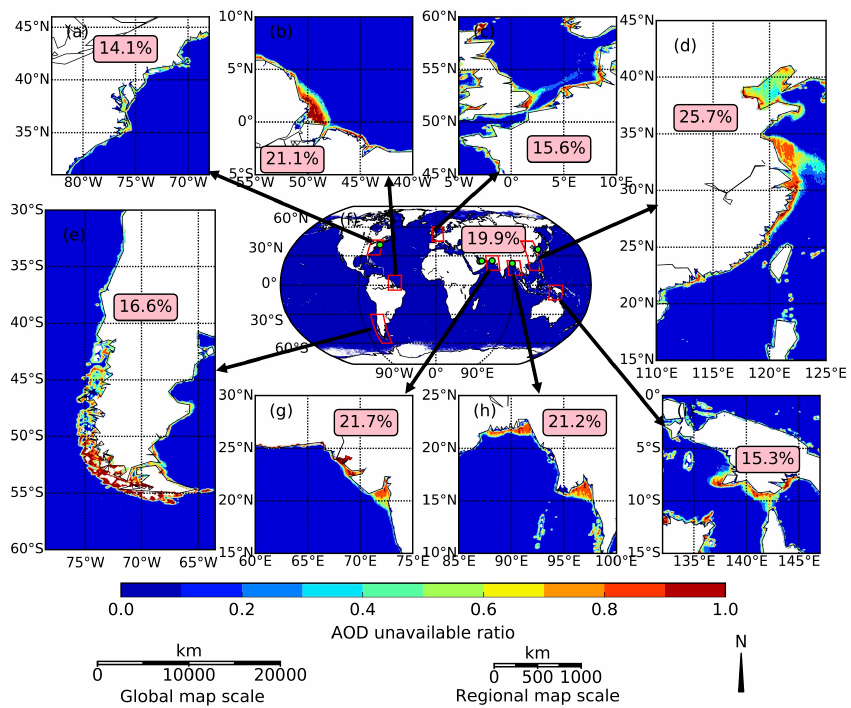
Figure 1. Regional ( a – e and g – i ) and global ( f ) distribution of AOD unavailable ratio which is defined as the ratio between number of non-retrieval pixels and all pixels in cloud-free conditions. MYD04 product in 2016 are used to conduct the statistics. Zoom in on the red-box regions of ( f ) are shown in ( a – e and g – i ). Lime points in ( f ) are AERONET sites used for validation and more information is in Table 1. Numbers in the pink boxes are AOD unavailable ratio over coastal water in clear sky condition.